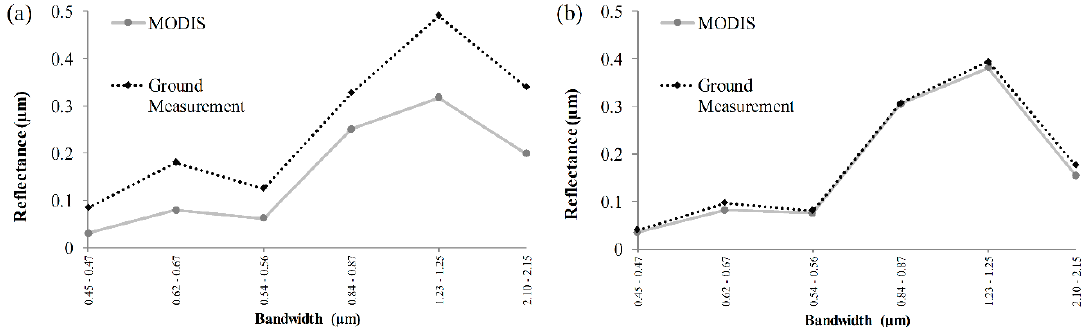
Figure 5. Comparing the average reflectance of LBA field measurements and Moderate Resolution Imaging Spectroradiometer ( MODIS) bands for: ( a ) Araguaia National Park and Cantão State Park, and ( b ) Ji-Paraná River Basin.